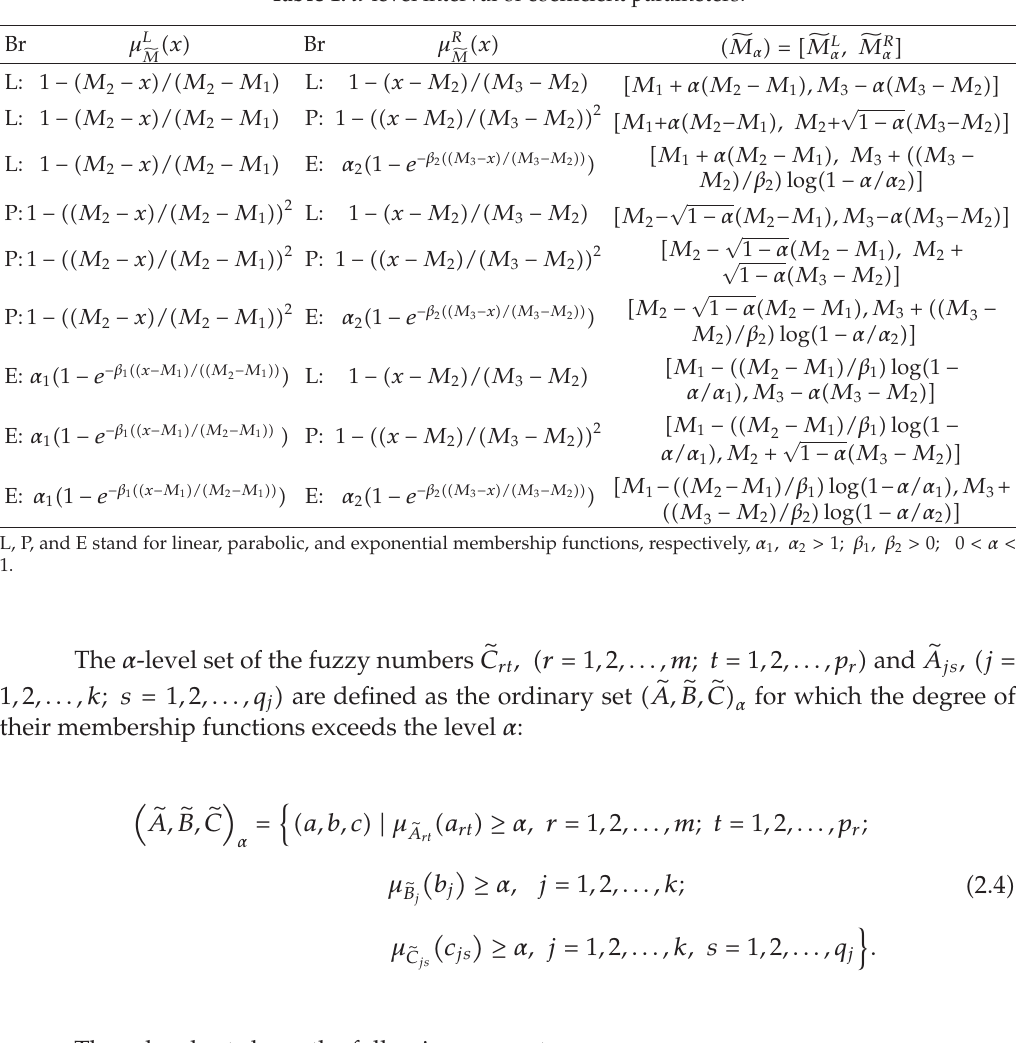
Table 1: α -level interval of coe ffi cient